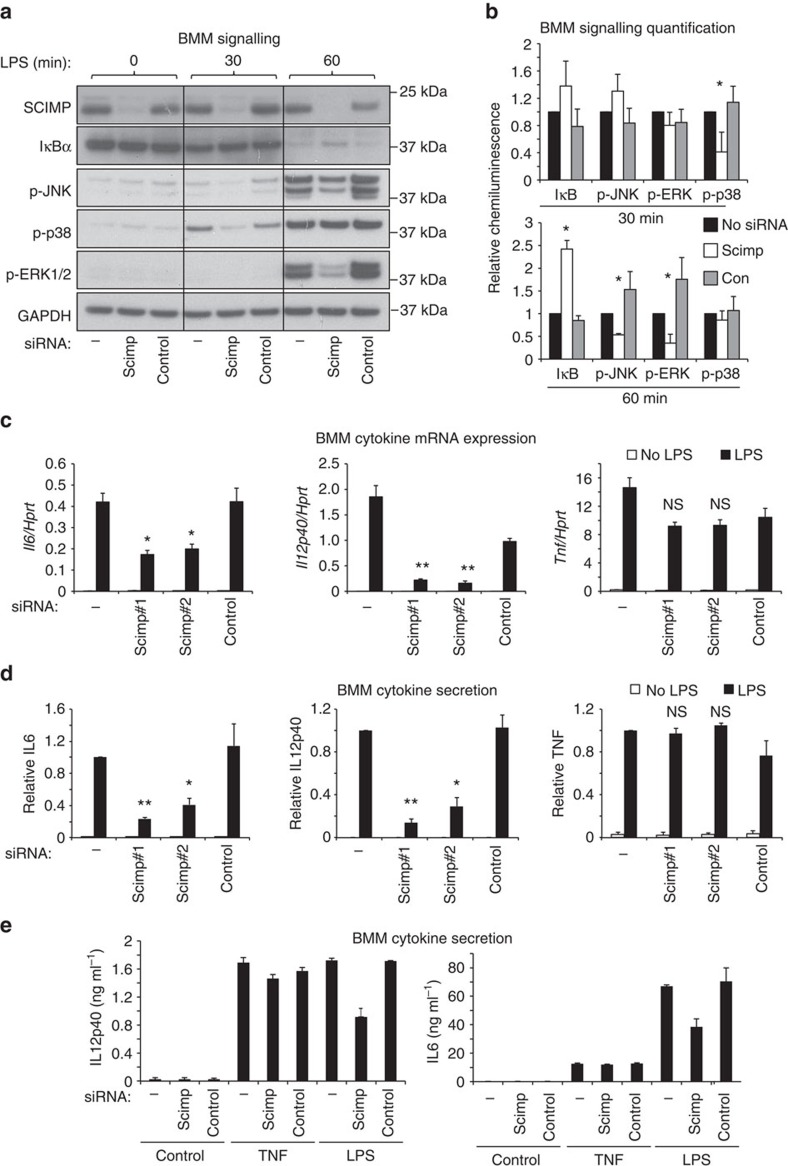
SCIMP is required for a subset of proinflammatory cytokine responses in macrophages.(a) SCIMP was silenced by siRNA in BMM. Representative immunoblots showing levels of SCIMP, IκB, phospho-JNK, phospho-p38 and phospho-ERK1/2 at 0, 30 and 60 min post-LPS stimulation. (b) Relative chemiluminescence of IκB, phospho-JNK, phospho-ERK1/2 and phospho-p38 was assessed at 30 min and 60 min post-LPS stimulation in SCIMP-silenced BMM. Graphs represent pooled data from n=3 experiments (mean+s.e.m.). (c,d) SCIMP silencing in BMM reduces proinflammatory cytokine production at the mRNA (c) and protein (d) level. Levels of individual mRNAs, relative to Hprt, at 4 h post-LPS stimulation were assessed by qPCR (n=4 experiments), and levels of secreted cytokines at 24 h post-LPS stimulation were assessed by enzyme-linked immunosorbent assay (ELISA; n=4 experiments). Graphs depict mean+s.e.m. (e) IL-6 and IL-12p40 protein levels were assessed by ELISA in SCIMP-silenced BMM treated with LPS or TNF for 24 h. Data is representative of two independent experiments. Graphs depict mean+range from technical repeats (n=2). Data in (a–d) are representative of, or combined from, at least 3 independent experiments. For (b–d), significance was assessed using one-way ANOVA (*P<0.05 and **P<0.01; NS, not significant).